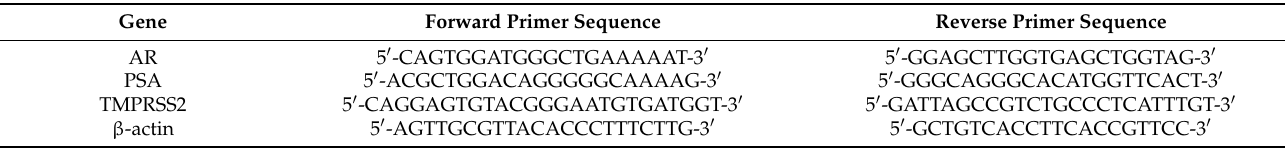
Table 1. Primer sequences for